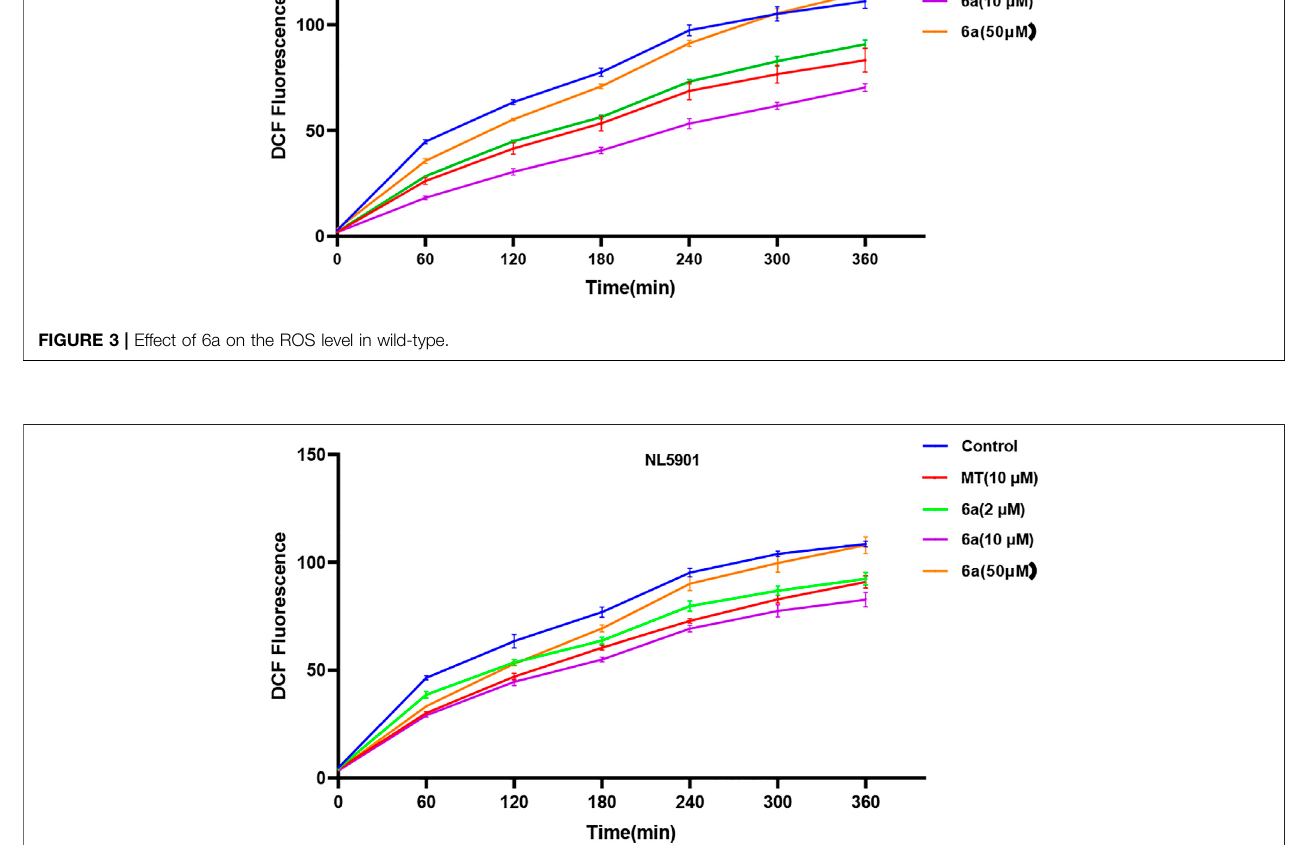
Frontiers in Chemistry |